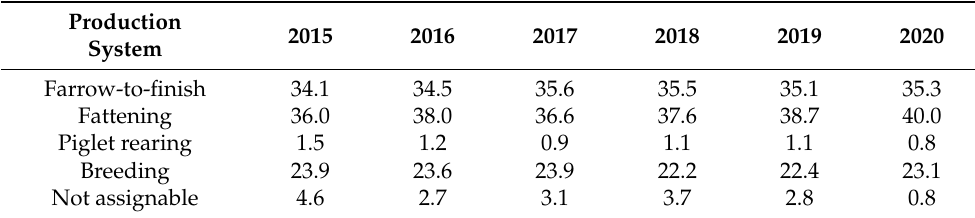
Table 1. Proportion in percent per year of antimicrobials dispensed for use in Austrian pigs for different farm types, based on mg/PCU.